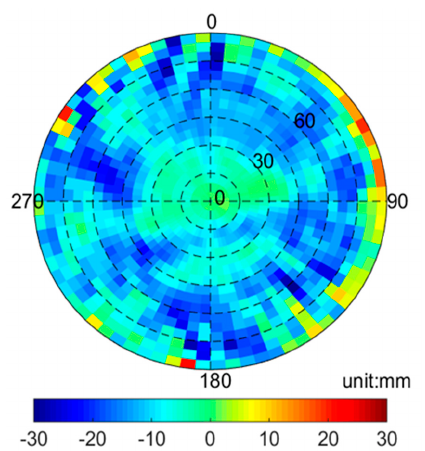
Figure 9. Receiver PCVs map from ionosphere-free combination for Jason-3 satellite.